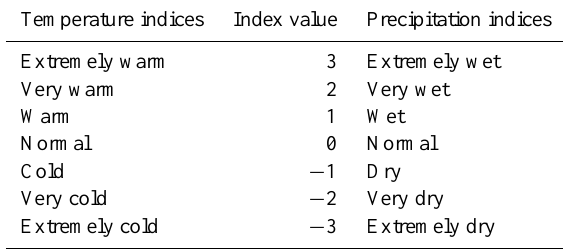
Table 2. Scale of the climate indices (Pfister,